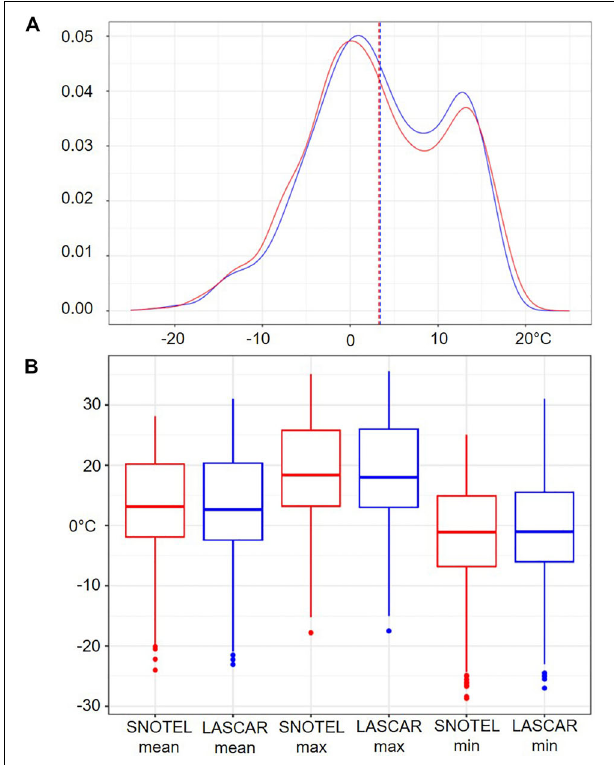
FIGURE 3 | (A) Density plot comparing daily Tmean of Lascar sensor (blue) and S1147 sensor (red). Mean values of each distribution are illustrated with a dashed line. (B) Boxplot illustrating Tmean, Tmin, and Tmax recorded by the sensors. Sensor values are depicted in blue and red for the Lascar and S1147,